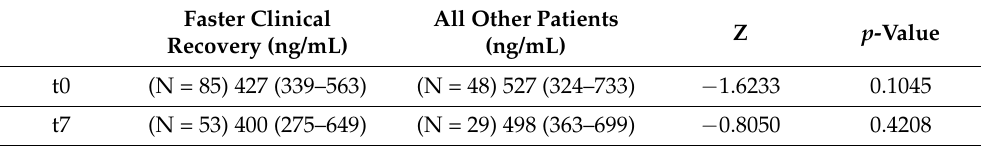
Table 3. Faster clinical recovery. Patients’ follow-up and OPN levels correlation. The levels of OPN were assayed with ELISA at day 0 (baseline, t0) and at day 7 (t7) of hospitalization. The table resumes the correlation data between patients with a faster clinical recovery ((NEWS2) ≤ 2 for at least 24 h in the first 2 weeks or discharge) vs. all other patients. Values are expressed as median (IQR). N, number of analyzed patients. Bold text evidence statistically significant results.